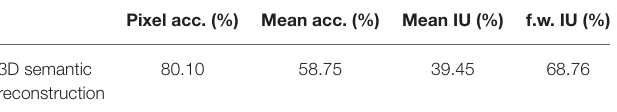
TABLE 6 | The overall performance of material semantic reconstruction in an industrial scenario.